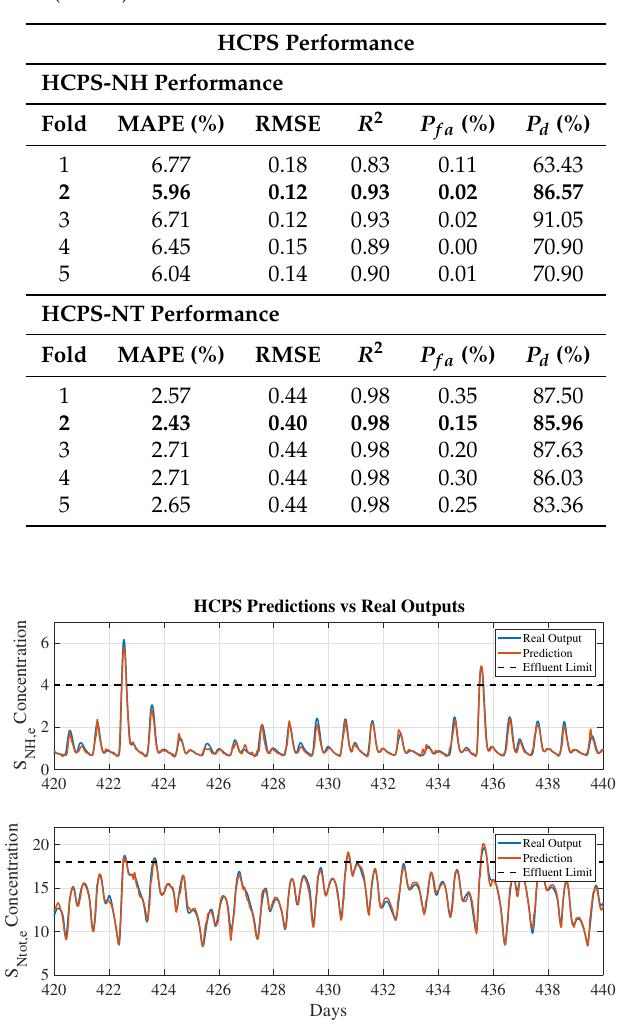
Table 5. Performance of HCPS structures adopting the K-Fold technique. Results in bold correspond to the fold offering the best performance in terms of the mean absolute percentage error (MAPE) and root-mean-square error (RMSE).